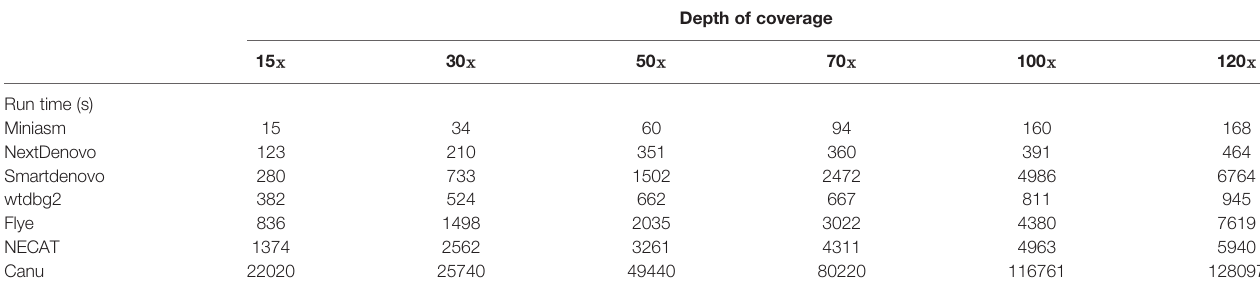
TABLE 2 | Comparison of runtime in computational test using different coverage depth